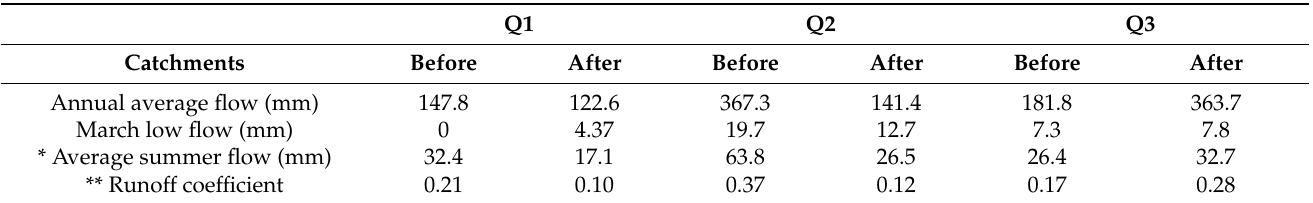
Table 2. Streamflow characterization within the experimental catchments at Quivolgo (average values pre- and post-fire).